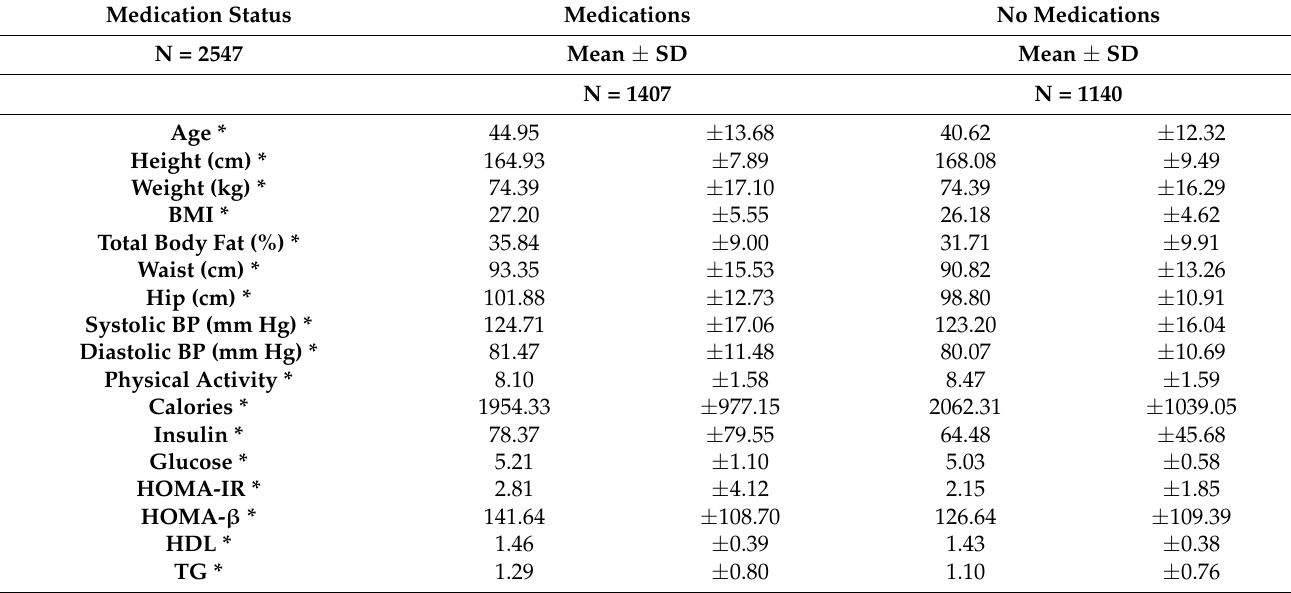
Table 3. Physical and metabolic characteristics of medicated and non-medicated